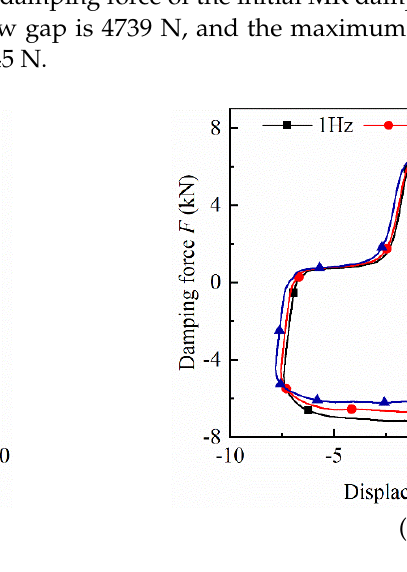
Figure 17. Damping force with amplitude of 7.5 mm: ( a ) initial; ( b ) optimal.